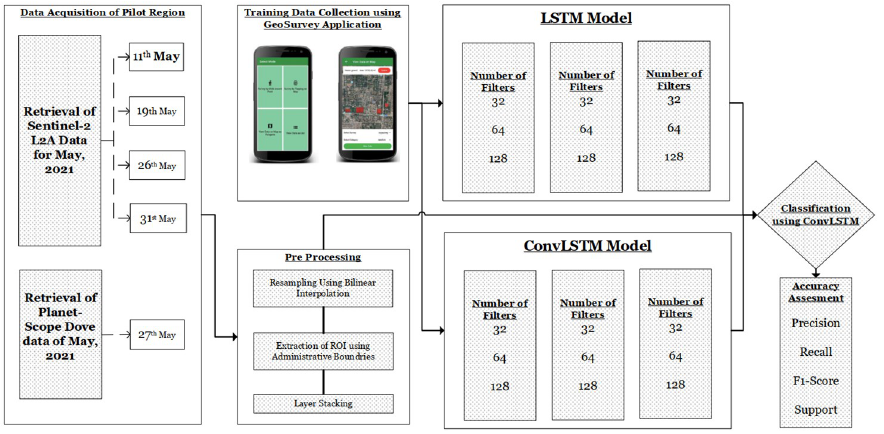
Fig 1. Flow chart of the methodology used in the